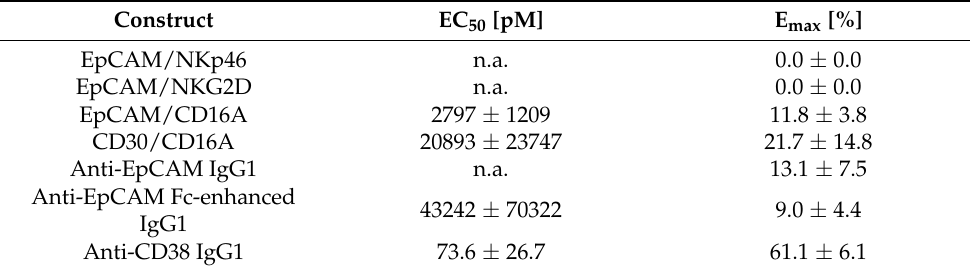
Figure 5. Assessment of NK cell fratricide induced by bispecific ICE ® constructs and anti-EpCAM IgG1. Calcein-labeled enriched primary human NK cells were co-cultured with autologous NK cells as effector cells at an E:T ratio of 1:1 in the presence of indicated antibodies at serial dilutions. After a 4 h incubation, the release of fluorescent calcein from lysed target cells into the supernatant was quantified and used for calculation of the percentage of specific lysis. Anti-CD38 IgG1 was used as a positive control. Mean of duplicate values ± standard deviation are plotted. Table 6. Potency and efficacy of bispecific ICE ® constructs and control antibodies determined in NK cell fratricide